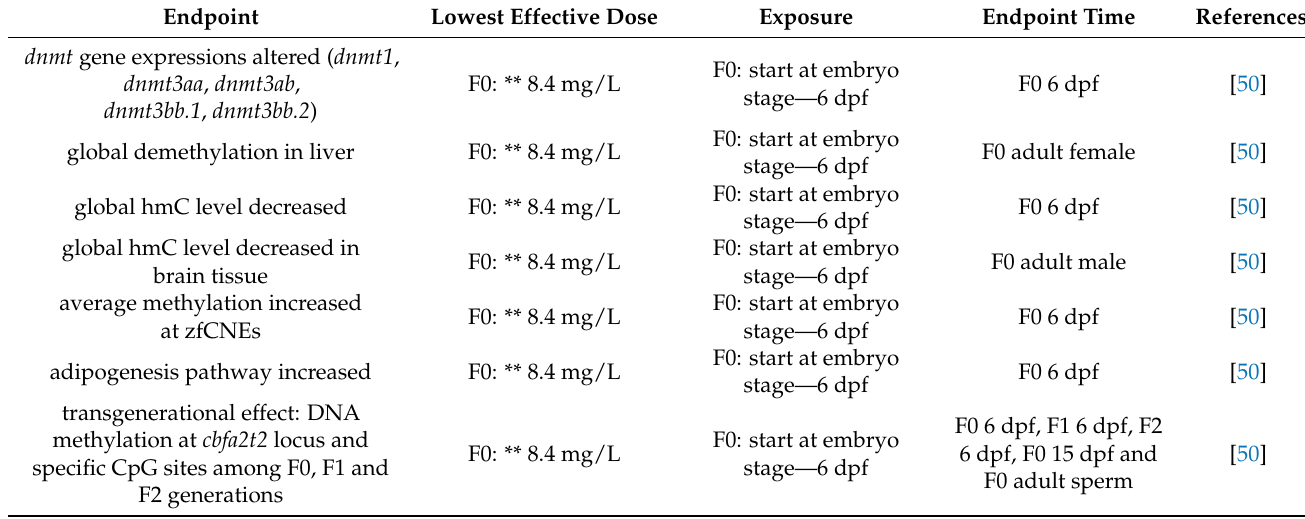
Table 9. Transgenerational effect from acute exposure to MEHP on zebrafish embryos. ** The concentration was converted from nM or µ M using the molar mass of MEHP 278.34